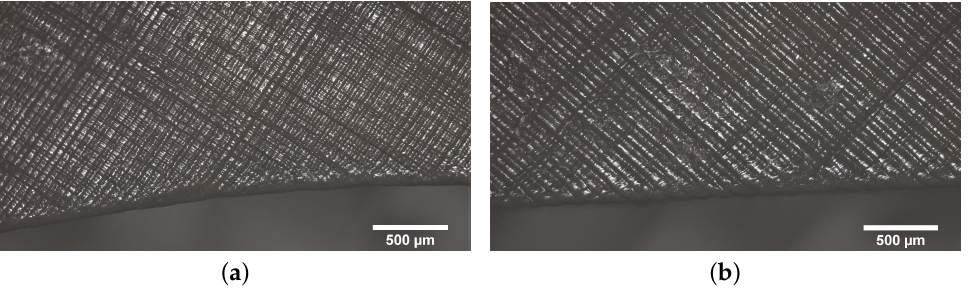
Figure 11. Effect of the Layer height in the surface finishing in samples printed at 45 ◦ . ( a ) 50 µ m; ( b ) 100 µ